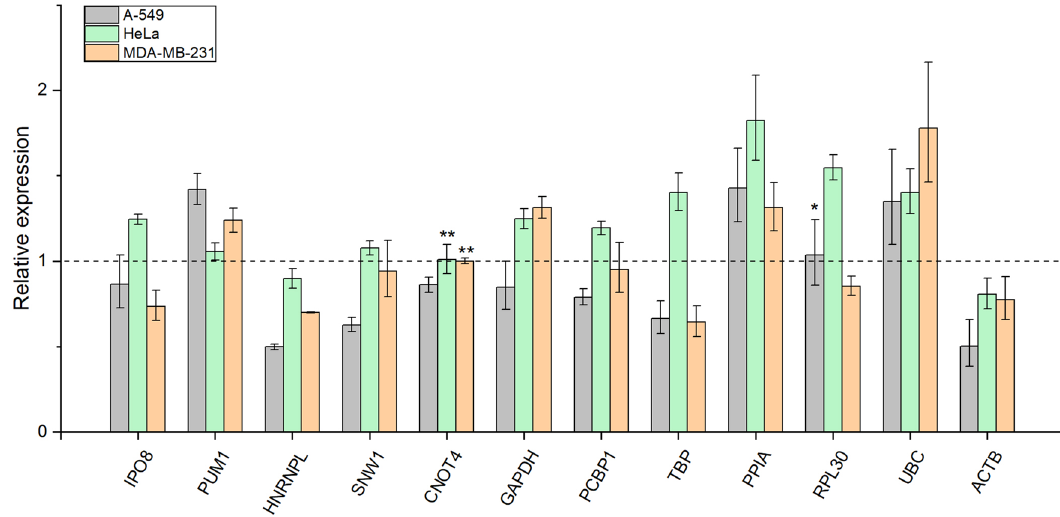
Figure 3. Relative expression of the candidate reference genes upon serum starvation. Relative expression values of serum starved cell lines can be compared to the average relative expression of the non-treated biological replicates selected as control and set to 1, which is represented by a dotted line. Error bars show standard deviation of three biological replicates (n = 3) for each cell line. The number of asterisks indicate increasing possibility that gene expression remains constant upon serum starvation. *p > 0.8, **p > 0.95 as calculated by the CFX Maestro software. This graph was created with OriginPro 2018 (OriginLab